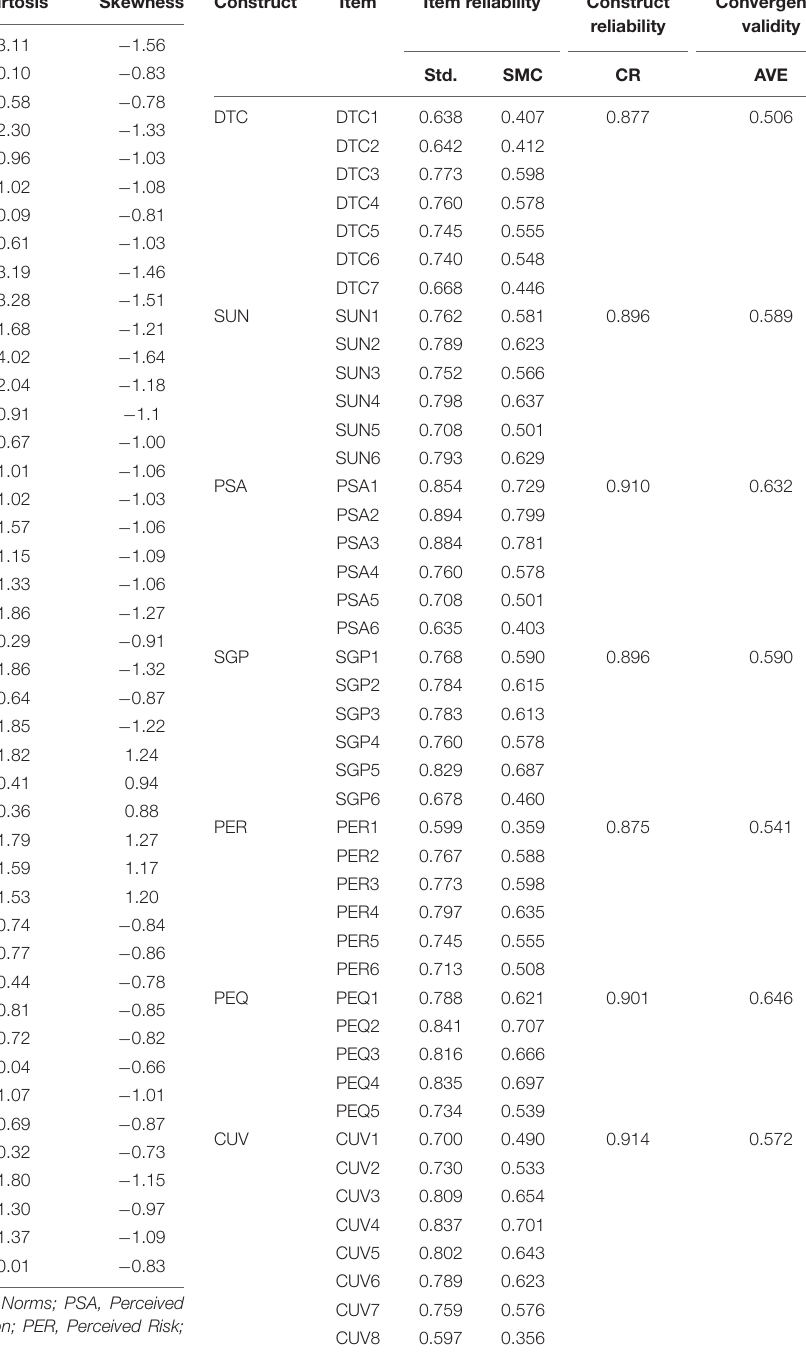
TABLE 3 | Results for the convergent